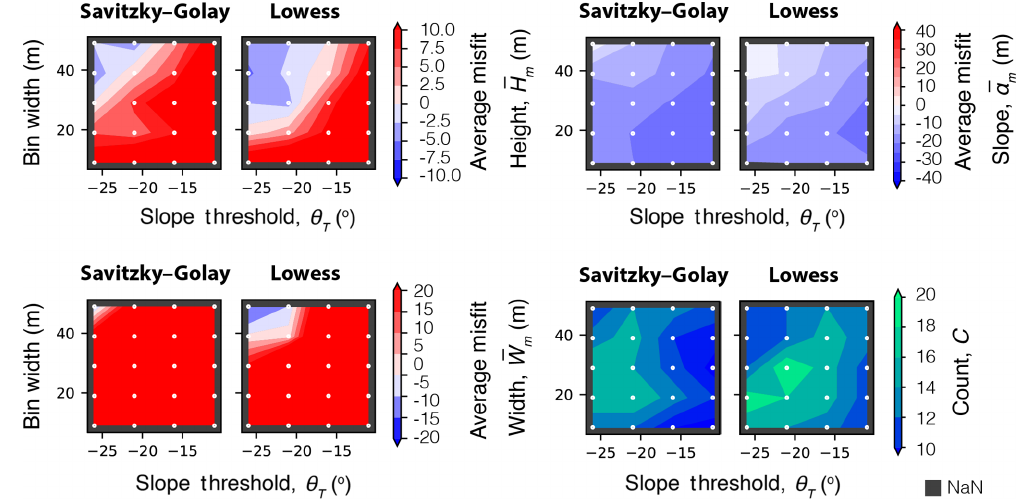
Figure 8. Average misfit values between algorithm and manual scarp parameters for 20 Bilila–Mtakataka fault profiles using the Pleiades 5m DEM.